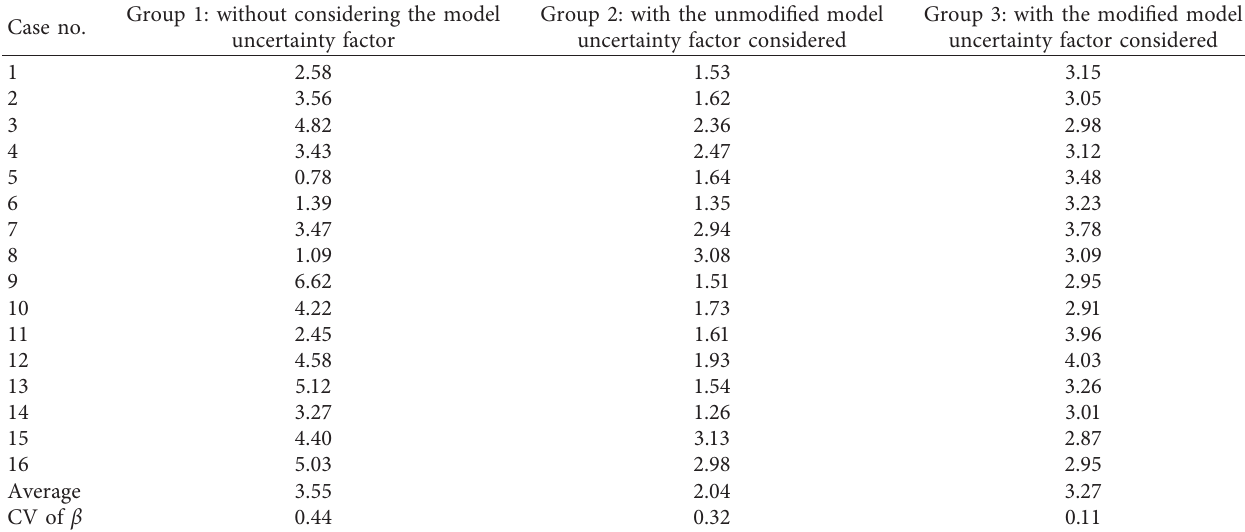
Table 15: Reliability index of 16 cases for AM Model.